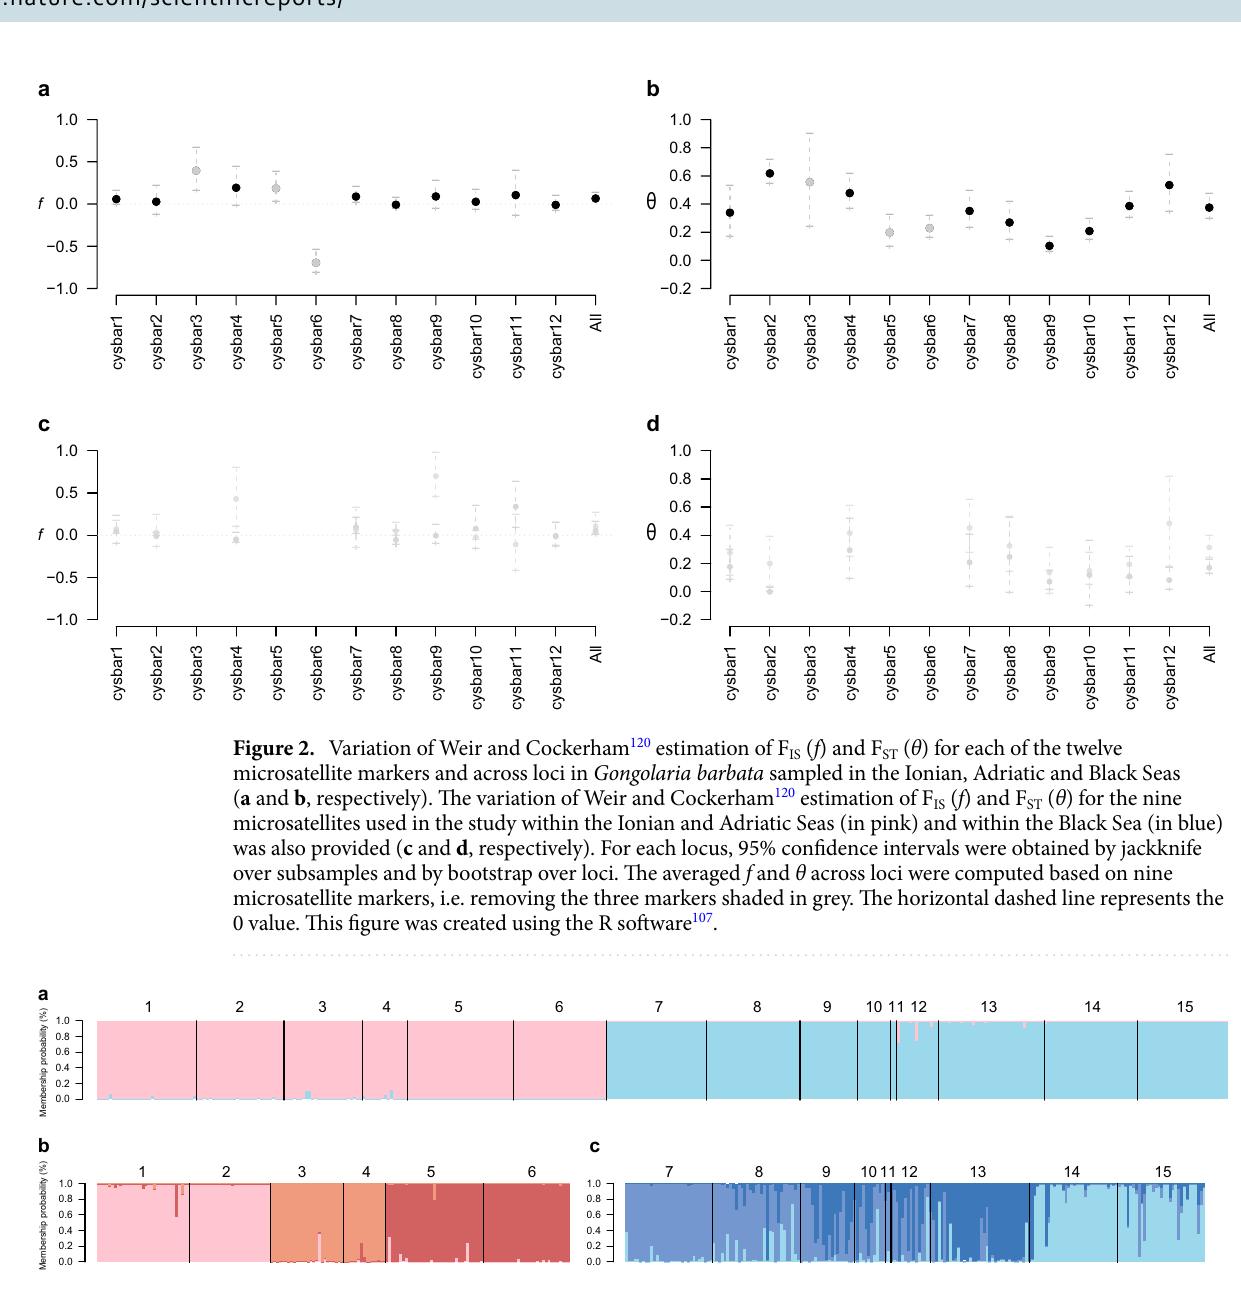
Figure 3. Genetic population structure of Gongolaria barbata based on nine microsatellite markers. Individual Bayesian ancestry proportions were determined using Structure with K = 2 across G. barbata distribution range ( a ), with K = 3 ( b ) within the Ionian and Adriatic Seas and with K = 3 ( c ) within the Black Sea. Black lines separate each study site. The clusters identified are distinguished by pink and blue colors, standing for the Mediterranean and Black Sea sites, respectively and referring to Fig. 1. Each individual is depicted as a vertical bar with colors distinguishing its ancestries to the clusters identified. Individuals’ assignment was visualized using the R software 106